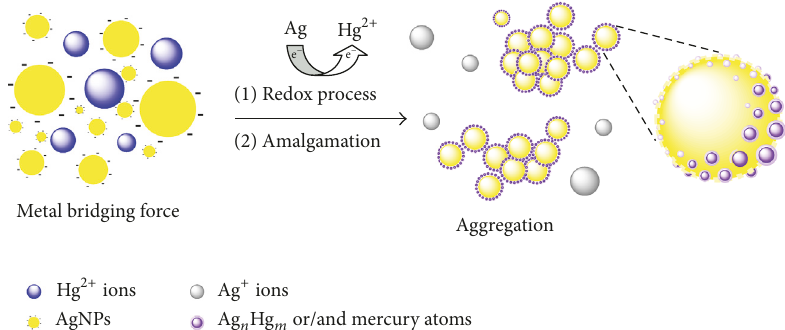
Figure 7: The proposed mechanism of the interaction between starch-coated AgNPs and Hg 2+